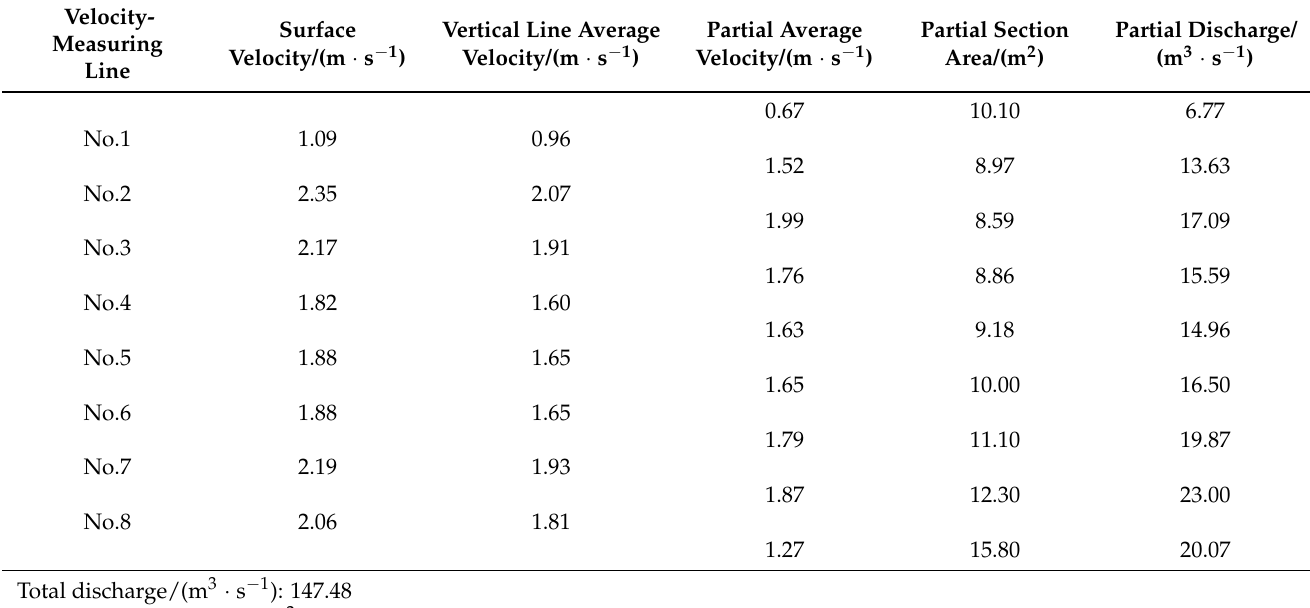
Table 4. Measurement results of the new method.